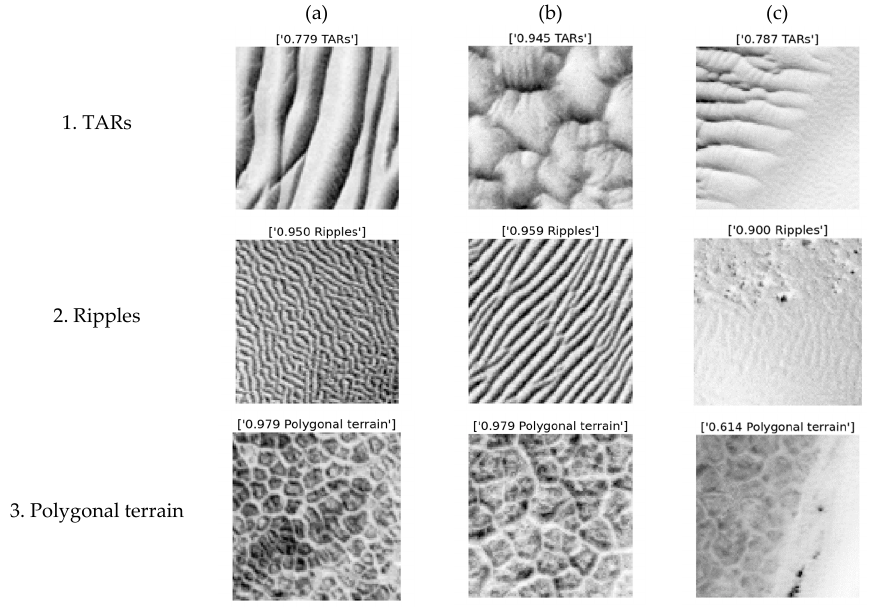
Figure 2. Correct identifications. The text above each image is the model’s score and label. Note the range of TAR (row 1) and ripple (row 2) morphologies that were correctly identified, and the model’s performance on impure tiles (column c). Table 2. The normalized network confusion matrix.